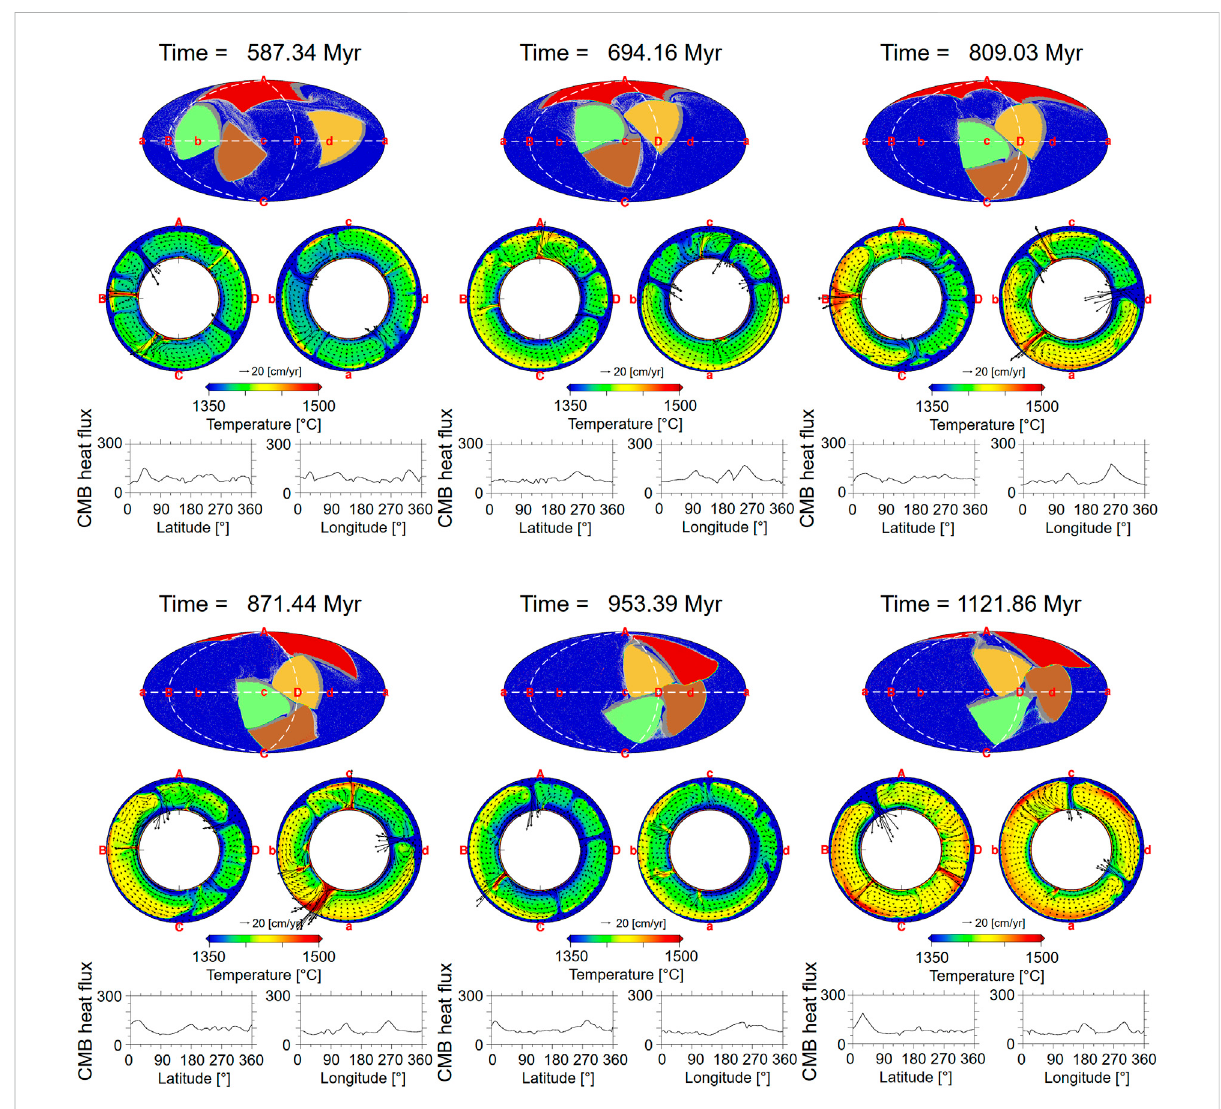
FIGURE 9 Snapshots ofdriftingcontinents (top oftheindividual “ Time ” stages), thelongitudinaland equatorialsectionsfor temperaturedistributioninthe mantle (middle panels) and the heat fl ow at CMB in the unit of mW/m 2 (bottom panels: left along a longitude through “ A ” (0 ° ) –“ B ” (90 ° ) –“ C ” (180 ° ) –“ D ” (270 ° ) –“ A ” (360 ° ), right along the equator through “ a ” (0 ° ) –“ b ” (90 ° ) –“ c ” (180 ° ) –“ d ” (270 ° ) –“ a ” (360 ° )) during the amalgamation period of numerical model shown in Figures 7, 8 (after Yoshida,